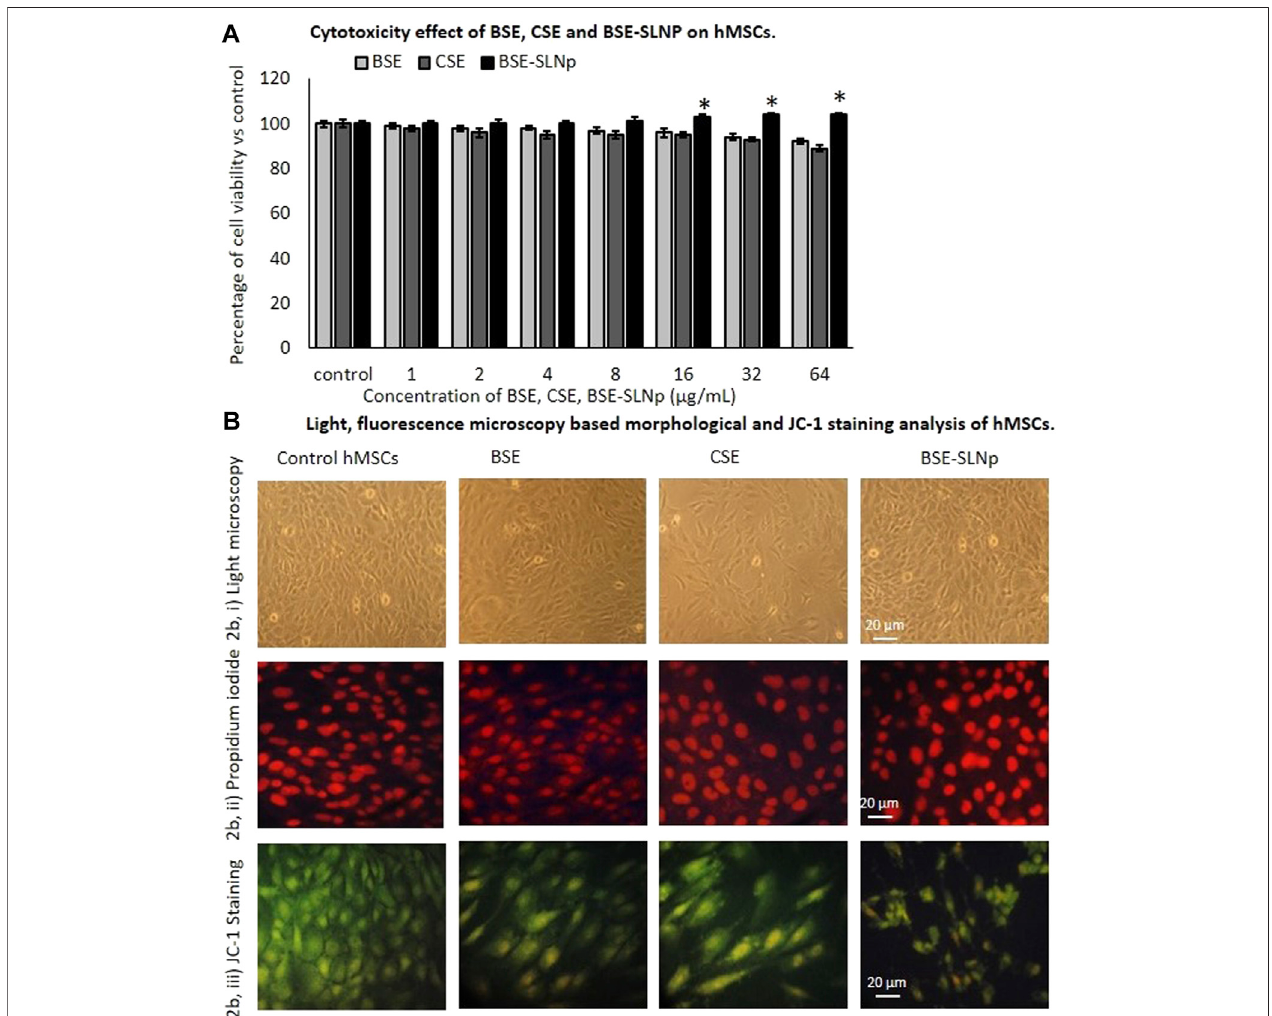
FIGURE 2 | In vitro cytotoxicity (2A) , light microscopic (2Bi) , propidium iodide (2Bii) , and JC-1 staining (2Biii) fl orescence microscopic image analysis of vehicle control,BSE,CSE,andBSE-SLNptreatedhumanmesenchymalstemcellsafter48 h.Eachvalueismeans ± SD( n (cid:2) 6).* p ≤ 0.05bycomparisonwithvehiclecontrol.In PIstaining,thenucleusappearedtobenormalandtherearenosignsofshrunken,pyknosis,orapoptoticnucleus.JC-1 fl uorescenceimagesshowingmergedimagesof the red and green signals of the dye, corresponding to JC-1 in J-aggregates vs. monomeric form. We found less J-aggregates and hypertrophic adipocyte in control cells. In BSE-SLNp treated adipocyte showing high J-aggregates directly representing (high MMP, Δψ m ) active mitochondria compared to BSE or CSE.